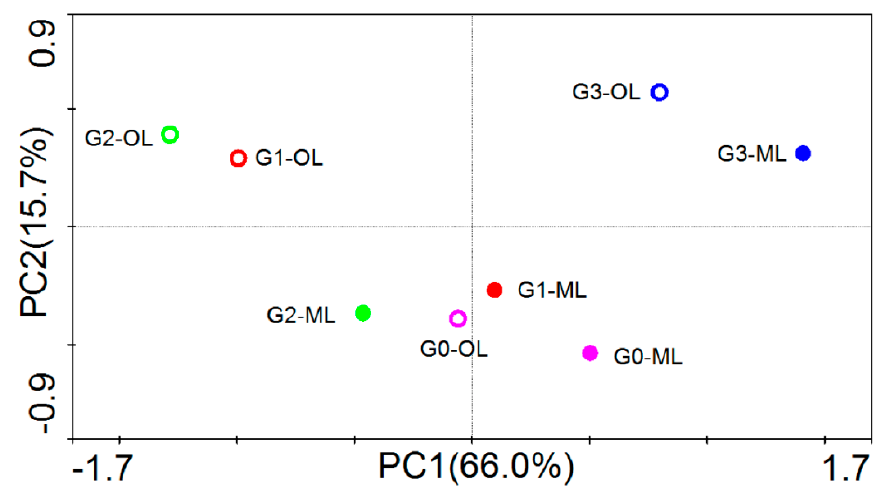
Figure 1. Principal component analysis (PCA) of fatty acids from different gap size in organic and mineral layer. G 1 : small gap; G 2 : medium gap; G 3 : large gap; G 0 : canopy; OL: organic layer; ML: mineral layer.